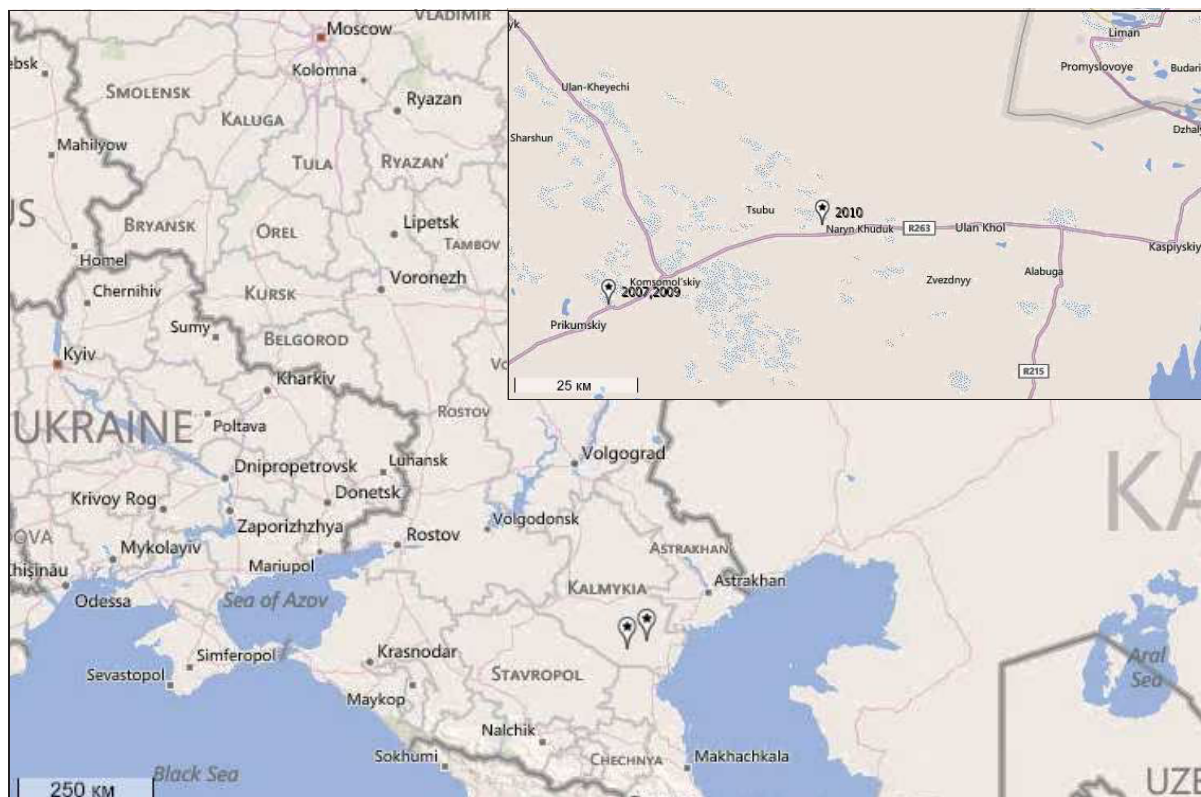
Fig. 1. Location of sites during the 2007, 2009, and 2010 Kalmykian expeditions.